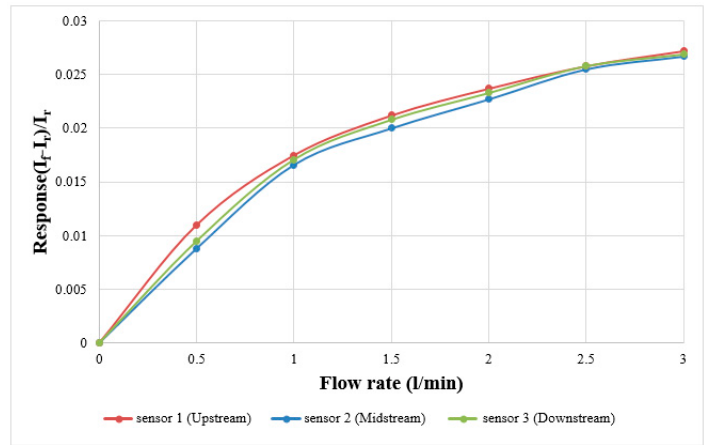
Figure 6. Flow calibration curve diagram.